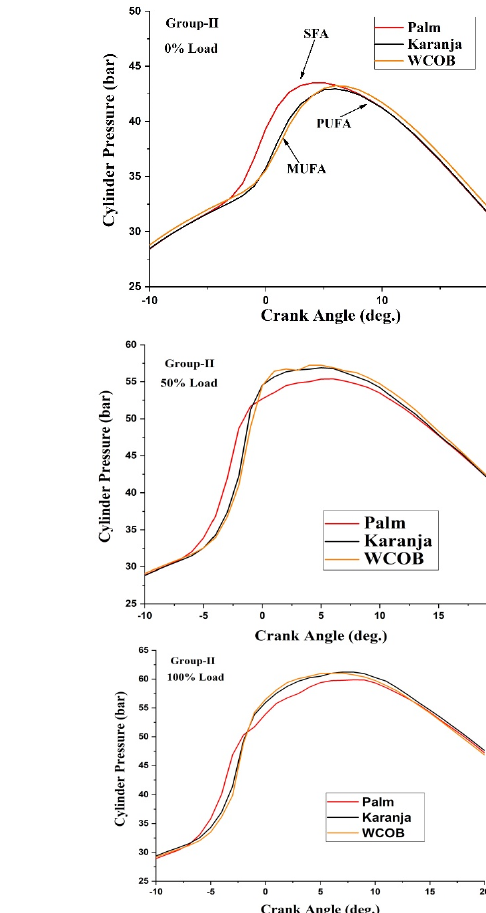
diesels, whereas at 100% load, castor biodiesel (highly MUFA) gave 4.5% and 2.1% higher